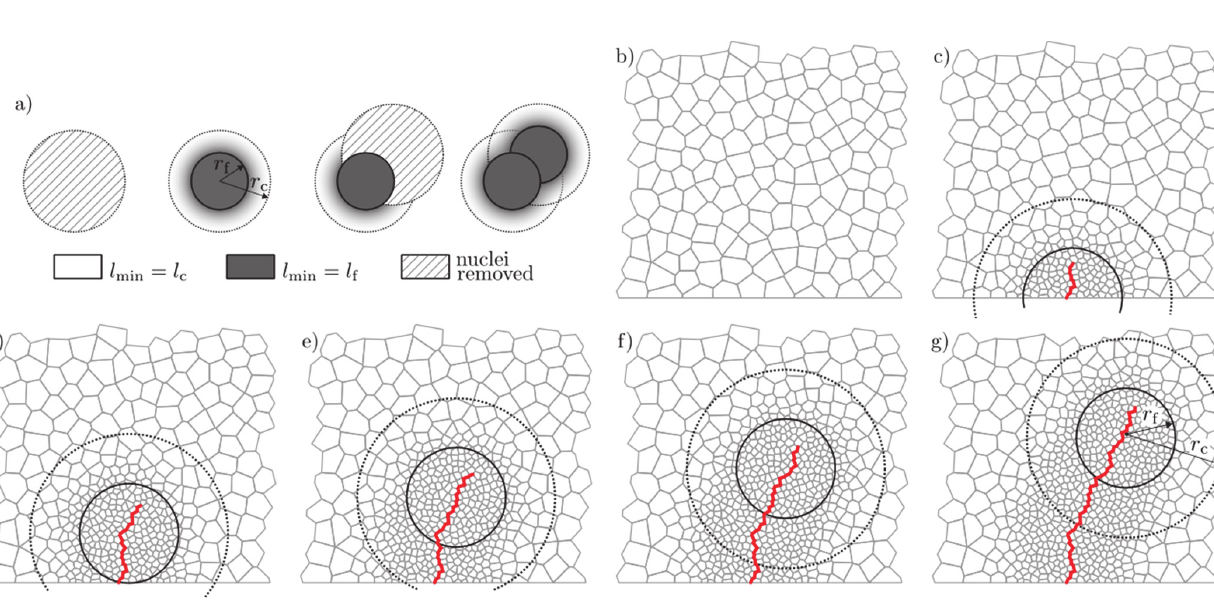
Figure 1: Adaptive refinement of discretization in steps; a) schematic explanation; b)-g) application to a 2D